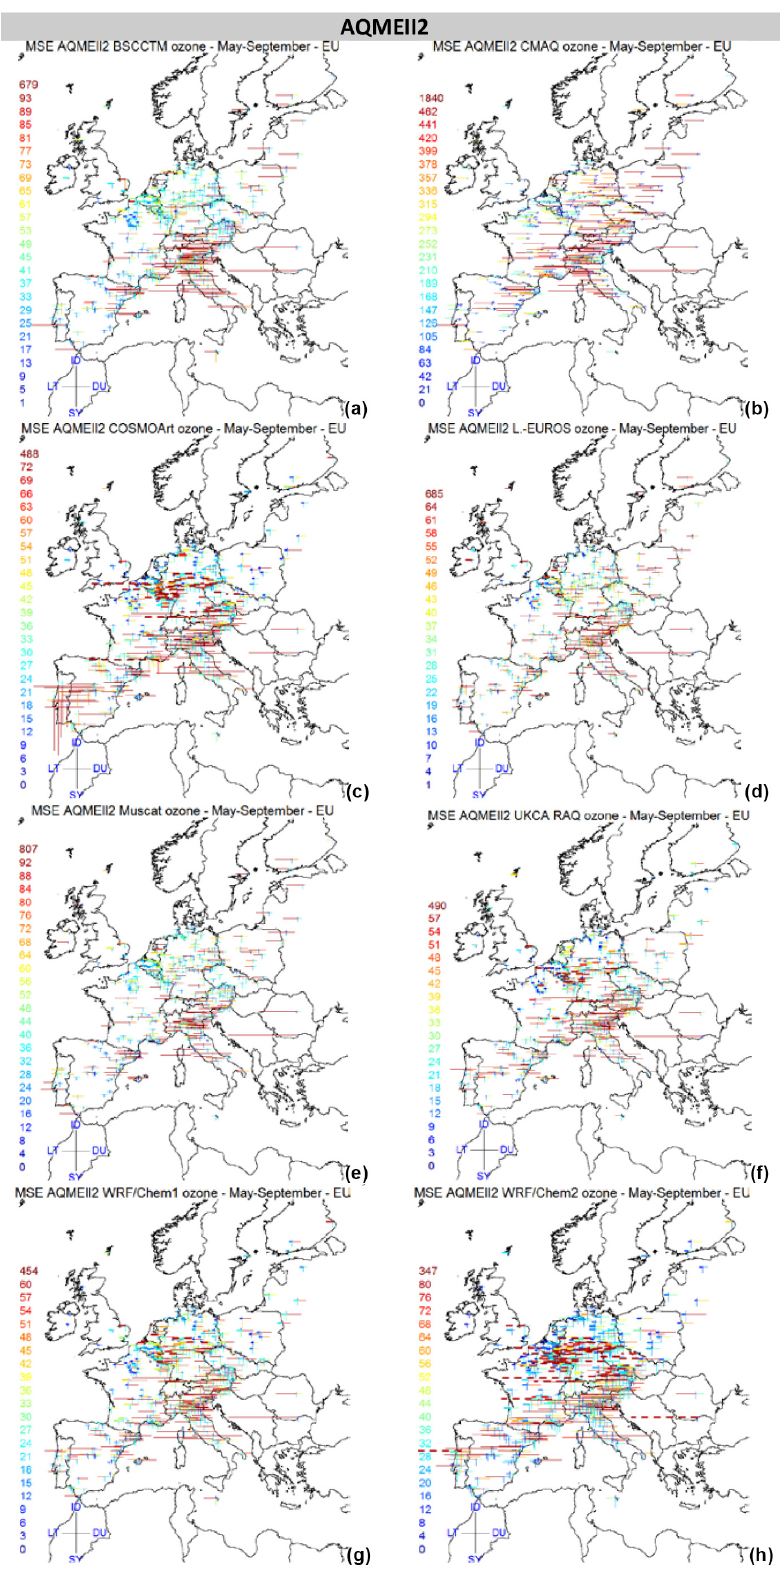
Figure 5. As in Fig. 3, but for the EU models of AQMEII2.